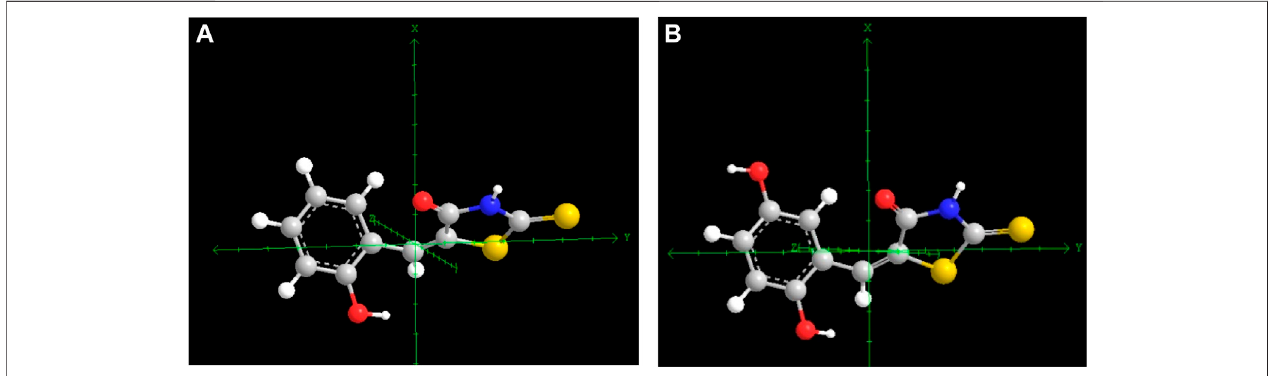
FIGURE 5 | Difference in the symmetry of structures molecules 1a (A) and 1c (B) respect to axes y..